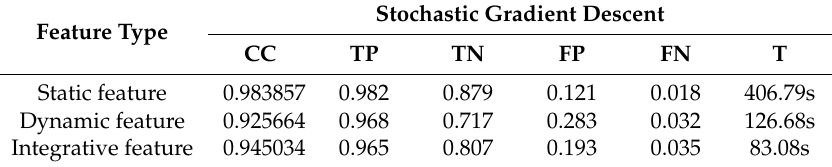
Table 4. The results of the stochastic gradient descent algorithm. CC (Correctly Classified rate, CC), TP (True Positive rate, TP), TN (True Negative, TN), FP (False Positive, FP), FN (False Negative, FN), T (training Time, T).